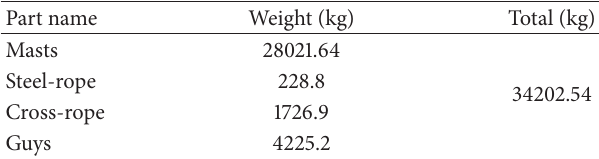
Table 1: The material list of cross-rope suspension